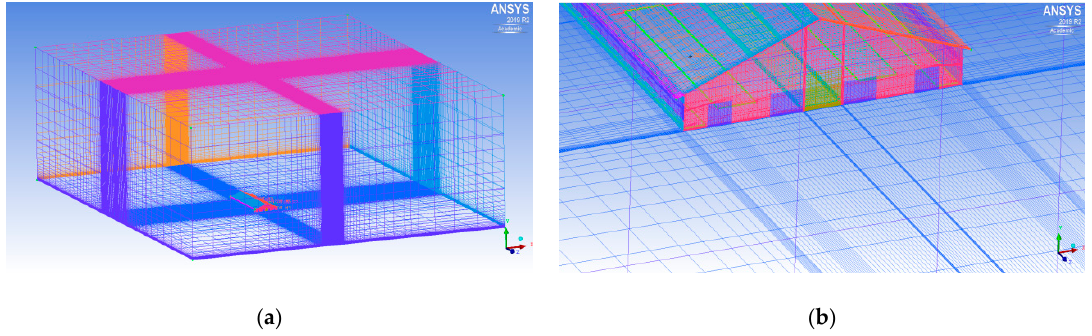
Figure 6. Grid distribution in the computational domain and at the building surfaces. ( a ) iso-metric view of the whole computational domain and ( b ) iso-metric view closed to the model.